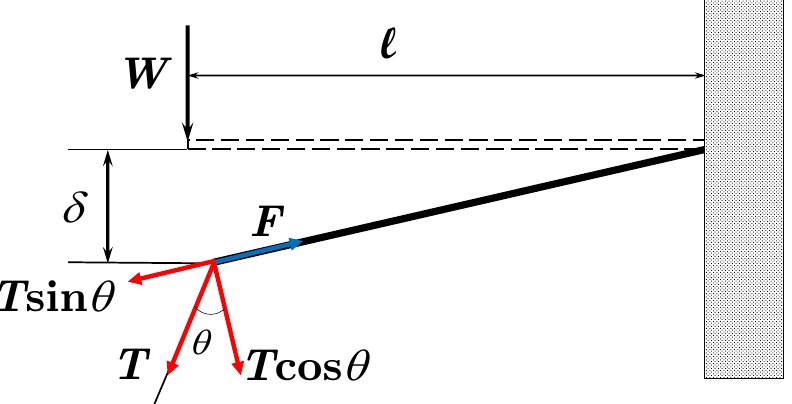
Figure 20. Cantilever-like approximate winding model.